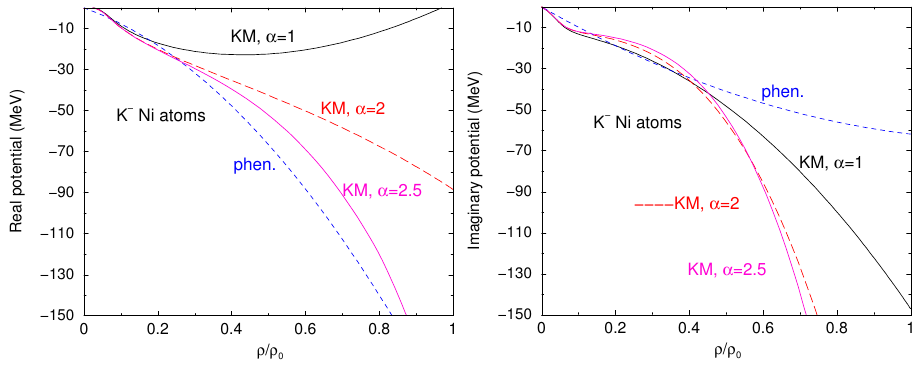
Figure 3. Best-fit K − optical potentials for kaonic atoms of Ni. Solid curves and long-dashed curves are based on the KM single-nucleon amplitudes plus a phenomenological term B ( ρ/ρ 0 ) α , dashed curves are for a purely phenomenological density-dependent best-fit potential [24]. All four potentials lead to equally good fits to the 65 data points for kaonic